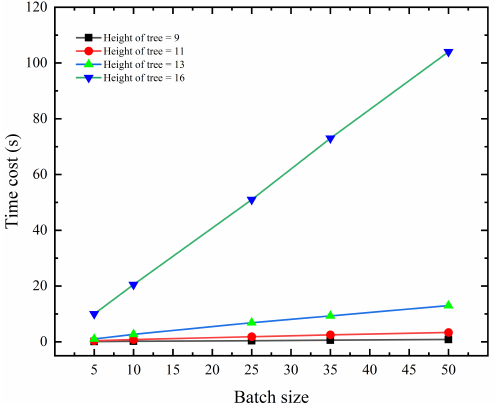
Figure 7. Time cost (s) of Algorithm 4, Build ZK-Rollup